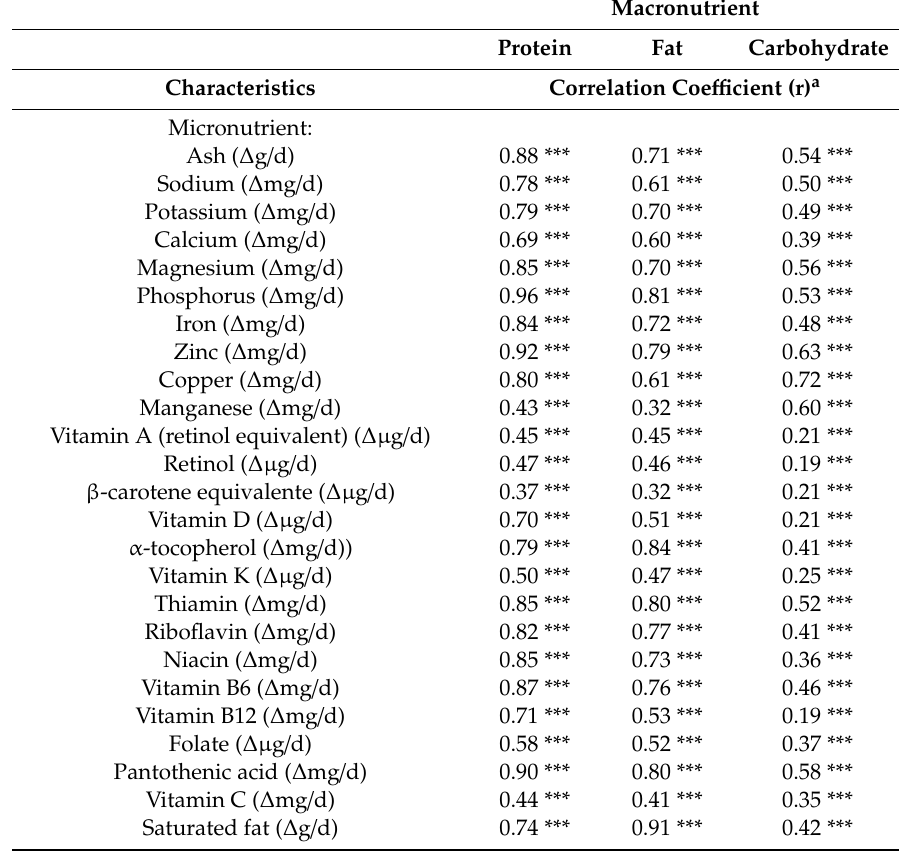
Table 3. Association between Macronutrient and Micronutrient change over 2